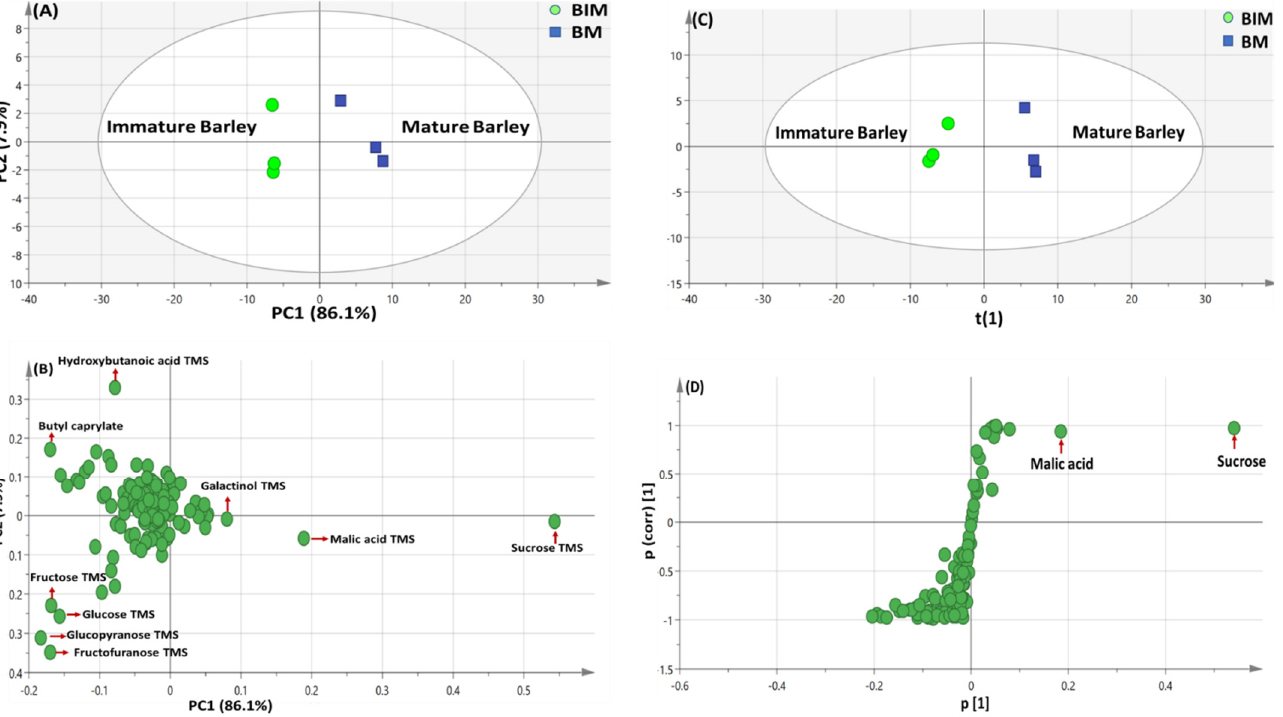
Figure 3. GC/MS-based principal component analyses (PCA) of metabolites analyzed in mature vs. immature H. vulgare (cv. Giza 3). ( A ) PCA score plot of PC1 against PC2. ( B ) Loading plot for PC1 and PC2, with contributing primary metabolites and their assignments. The metabolome clusters are located at the distinct positions in two-dimensional space described by two vectors of principal component 1 (PC1) = 86.1% and PC2 = 7.9%. ( C ) OPLS-DA score plot derived from modeling silylated primary metabolites of mature vs. immature H. vulgare specimens ( sp. Giza 3) ( n = 3). The respective loading S-plots ( D ) show the covariance p[1] against the correlation p(cor)[1] of the variables of the discriminating component of the OPLS-DA model with a p -value of 0.1. Designated variables are highlighted and identifications are discussed in the text.